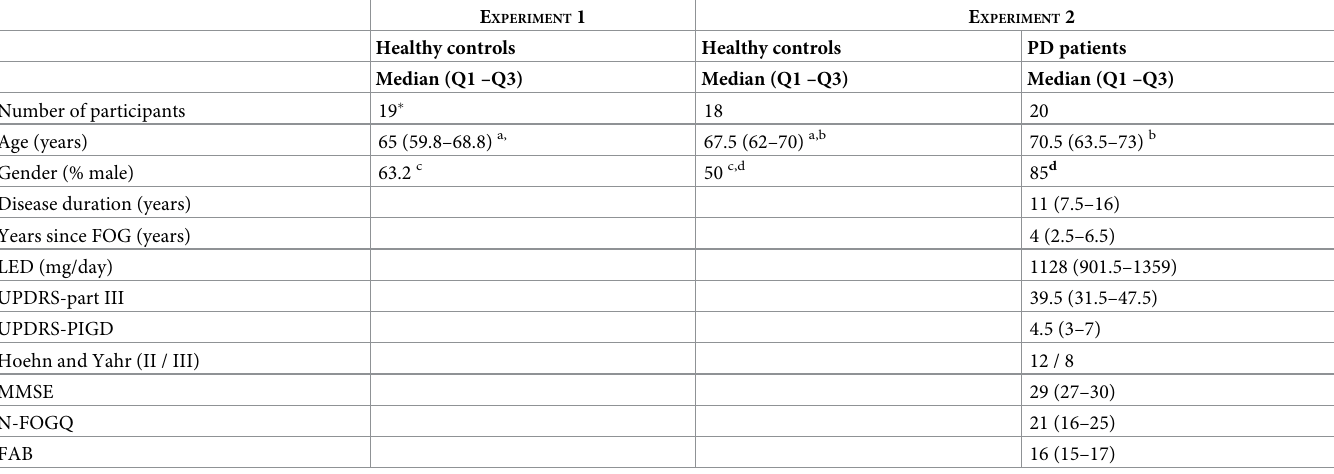
Table 1. Clinical characteristics of the